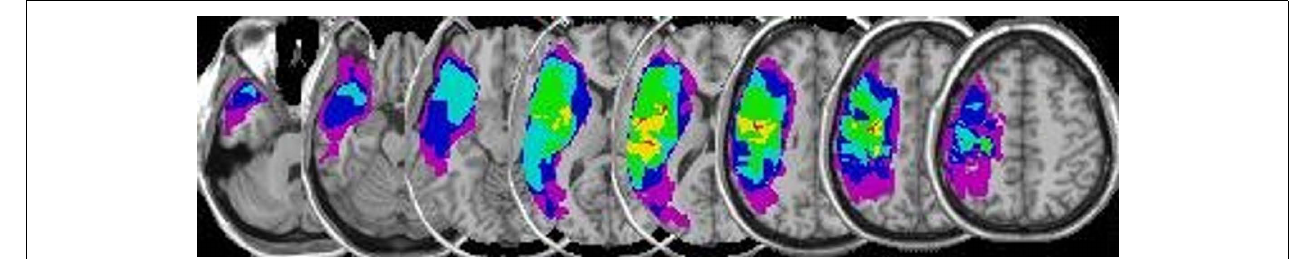
the left hemisphere).The color scale indicates the extent of overlap among patients with green, yellow, and red indicating overlapping voxels of lesion maps of 4, 5, and 6 patients respectively.